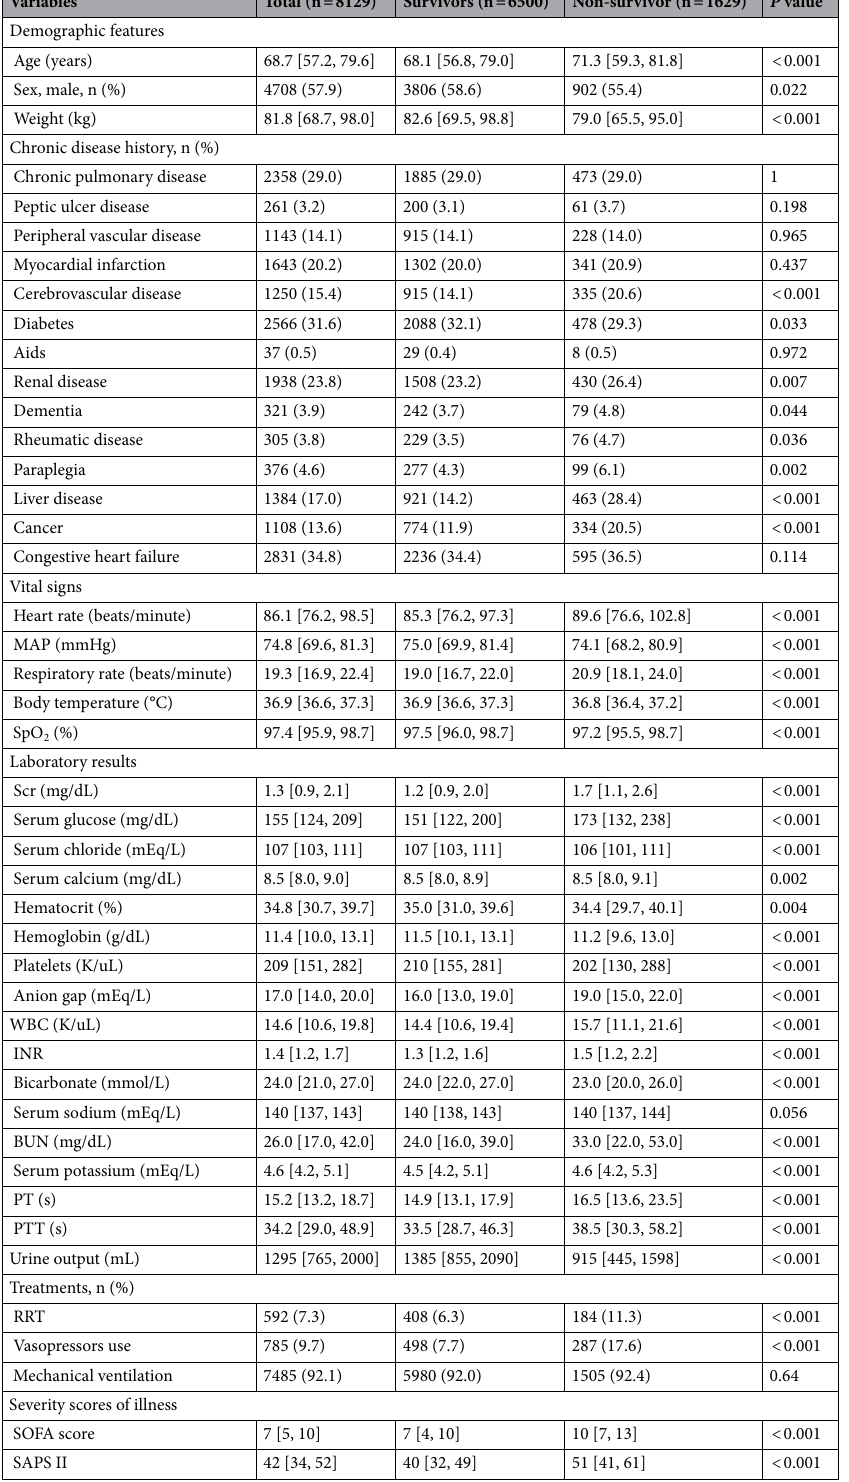
Table 1. Demographic and clinical characteristics at baseline. AIDS Acquired immune deficiency syndrome, MAP Mean arterial pressure, SpO 2 Oxygen saturation, WBC White blood cell, BUN Blood urea nitrogen, INR International normalized ratio, PT Prothrombin time, PTT Partial thromboplastin time, RRT Renal replacement therapy, Scr Serum creatinine, SOFA Sequential organ failure assessment, SAPS II Simplified acute physiology score